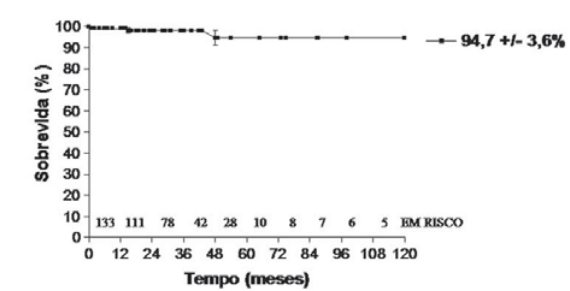
Fig. 2 - Sobrevida atuarial